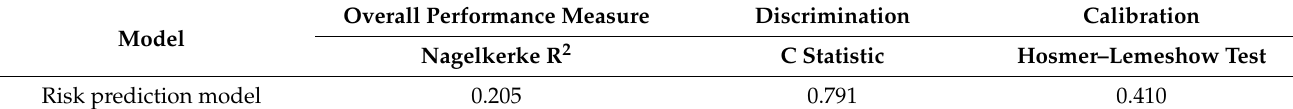
Table 5. Performance measures using logistic regression for the prediction of the 6-month mortality risk. Model